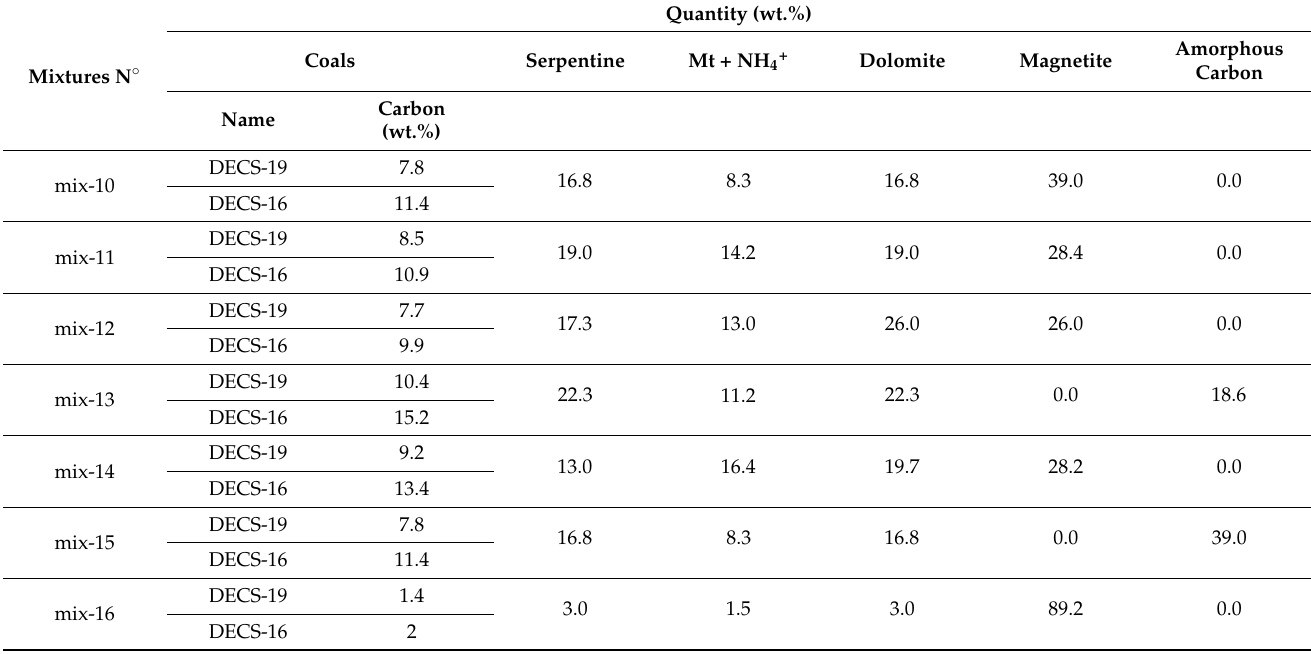
Table 2. Composition of the mixtures prepared as Ceres’ organic-rich analogues. Quantities are in wt.%. Quantity (wt.%) Coals Serpentine Mt + NH 4+ Dolomite Magnetite Mixtures N ◦ Carbon